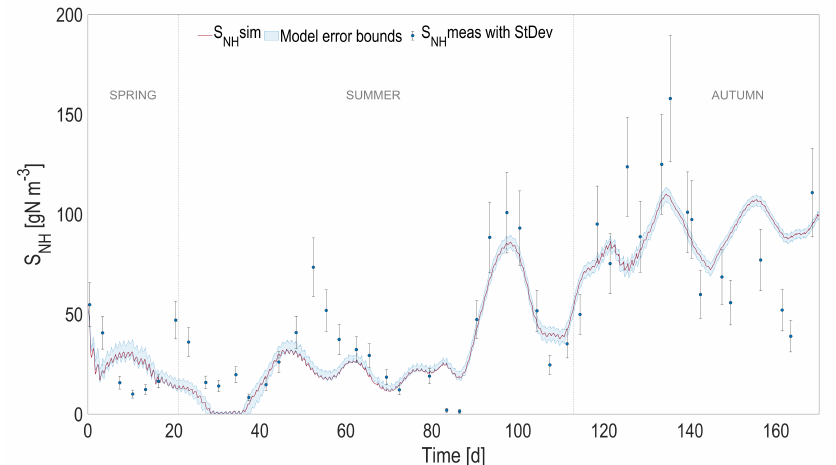
Figure 6. Full prediction capability of the coupled heat transfer and ALBA models. Comparison between full predictions (with simulated temperature) and measurements, for ammoniacal nitrogen ( S NH ). Shaded areas on model predictions represent the related 95% confidence intervals. 4